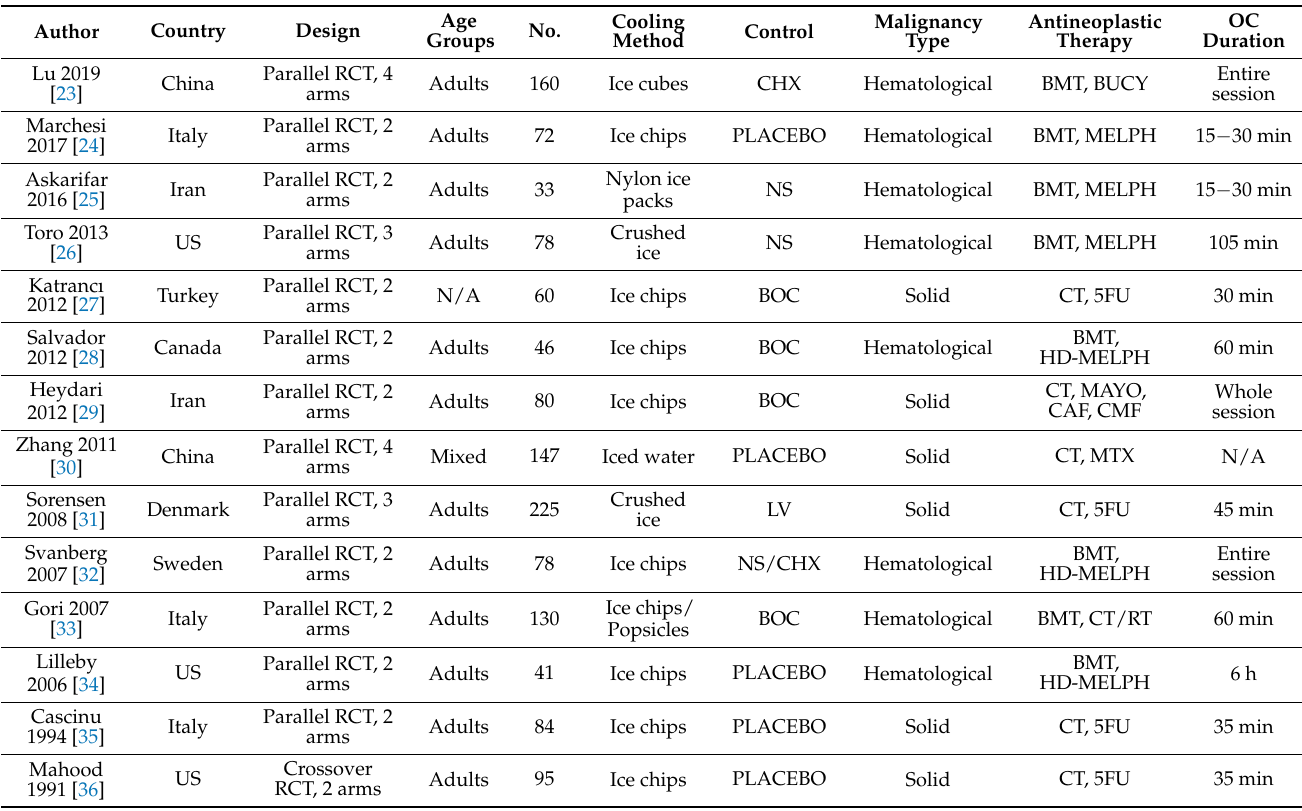
Table 1. Characteristics of studies included in